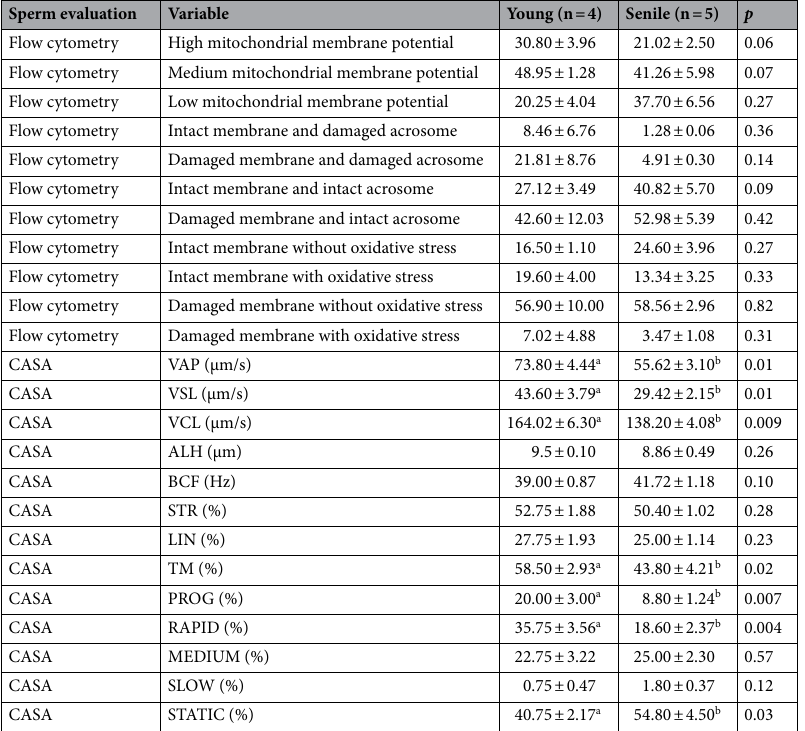
Table 2. Sperm Evaluation performed by flow cytometry and computer-assisted sperm analysis (CASA). VAP average pathway velocity, VSL straight-line velocity, VCL curvilinear velocity, ALH amplitude of lateral head displacement, BCF beat cross frequency, STR straightness, LIN linearity, TM total motility, PROG progressive motility, RAPID rapid velocity, MEDIUM medium velocity, SLOW slow velocity, STATICS non-moving sperm. Different superscript letters in each bar represent p < 0.05, as indicated by statistical